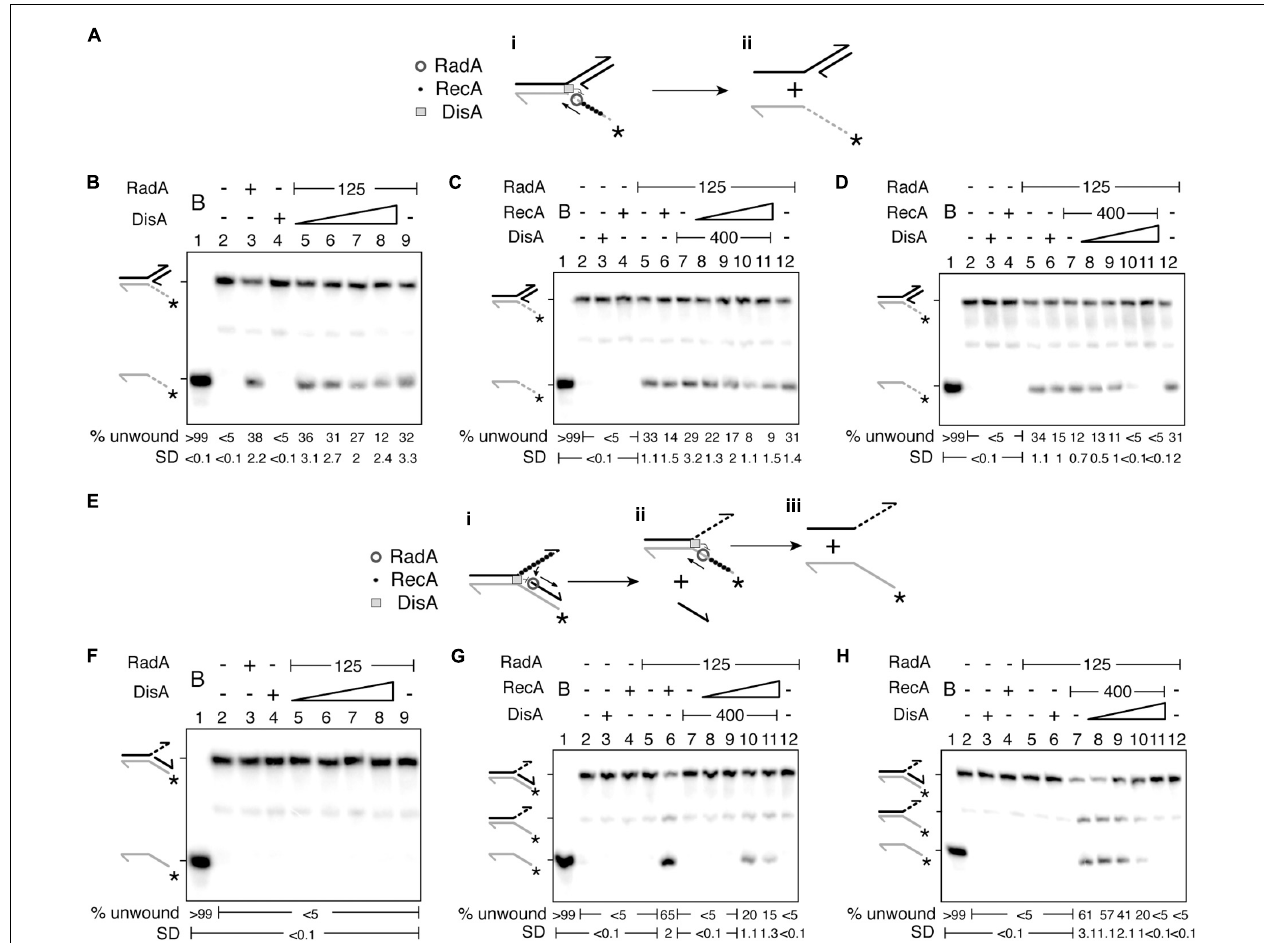
FIGURE 3 | DisA inhibits RadA/Sms unwinding. (A) Cartoon illustrating how RadA/Sms unwinds a 3 (cid:48) -fork DNA substrate in the presence of DisA and RecA. RadA/Sms unwinds the substrate from its 5 (cid:48) tail (i-ii), originating a 5 (cid:48) -tailed intermediate, but DisA bound at the junction and RecA bound at the ssDNA 5 (cid:48) tail inhibit RadA/Sms-mediated unwinding. (B–D) Helicase assays with 3 (cid:48) -fork DNA. The DNA was incubated with a fixed amount of RadA/Sms (and RecA in D ) and increasing concentrations of DisA (100–800 nM) (B,D) ; or with a fixed amount of RadA/Sms and DisA and increasing concentrations of RecA (50–400 nM) (C) . (E) Cartoon illustrating how RadA/Sms unwinds a 5 (cid:48) -fork DNA substrate in the presence of DisA and RecA. RecA filamented at the ssDNA 3 (cid:48) tail loads RadA/Sms at the junction on the nascent lagging strand. Then, RadA/Sms unwinds the substrate (i,ii), originating a forked intermediate and the nascent lagging strand, but DisA bound at the junction inhibit RadA/Sms-mediated unwinding (i-ii). (F–H) Helicase assays with 5 (cid:48) -fork DNA. The DNA was incubated with a fixed amount of RadA/Sms (and RecA in H ) and increasing concentrations of DisA (F,H) ; or with a fixed amount of RadA/Sms and DisA and increasing concentrations of RecA (G) . Reactions were done in buffer A containing 2 mM ATP (15 min, 30 ◦ C), and after deproteinization the substrate and products were separated by 6% PAGE and visualized by phosphor imaging. The quantification values of unwound DNA and the SD of > 3 independent experiments are documented. B, boiled DNA substrate; − and +, absence and presence of the indicated protein; * and gray color, the labeled strand; half of an arrowhead, the 3 (cid:48)